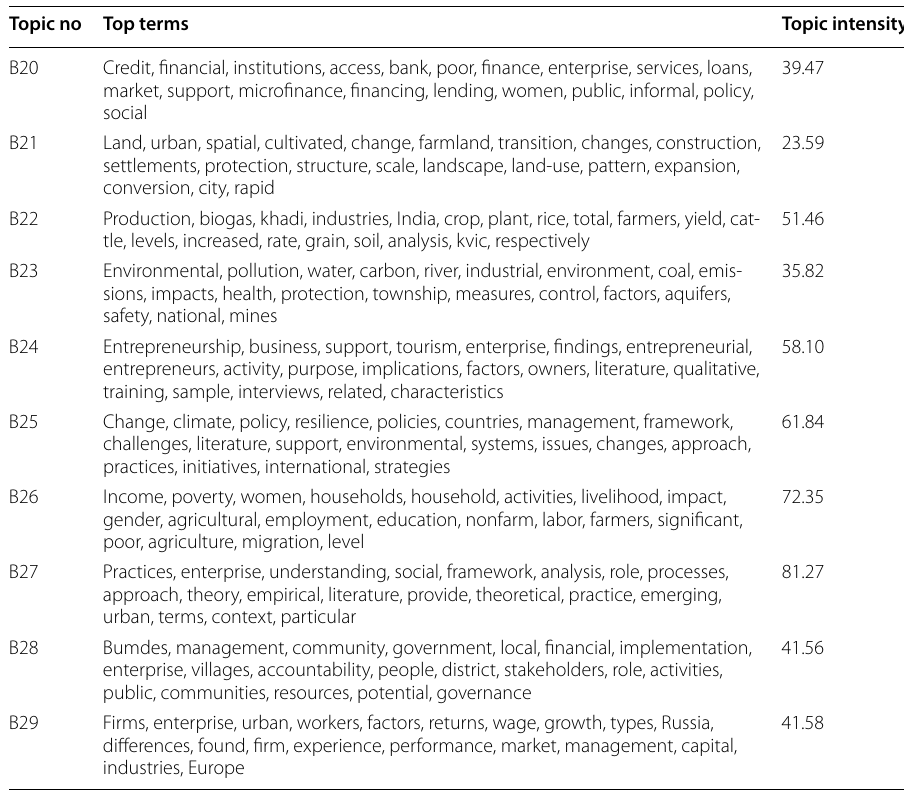
Table 3 20 top-terms from some of the topics from the topic model with topic size k